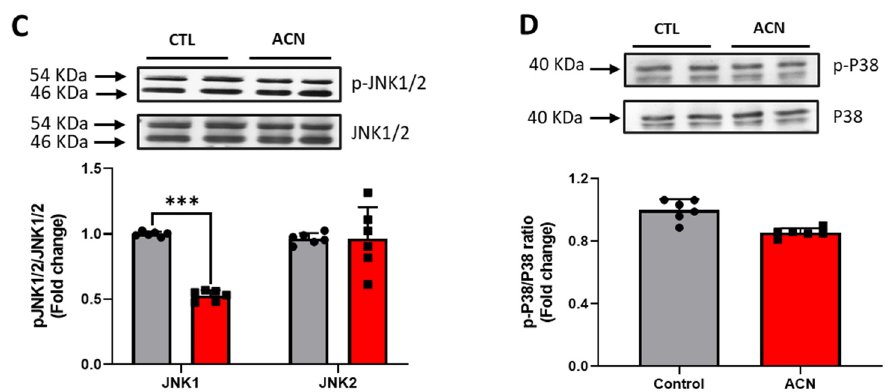
Figure 3. Immunoblotting analysis of proteins extracted from the hippocampus. Crude lysates (20– 40 µg protein) were immunoblotted with antibodies that specifically recognise ( A ) phospho- ERK1/2, total ERK1/2; ( B ) α -E-catenin and GAPDH; ( C ) phospho-JNK1/2, total JNK1/2 and ( D ) phospho-p38, total-p38. Results (phospho/total ratio for ERK1/2, JNK1/2, and p38; protein/GAPDH ratio for α -E-catenin) are presented as means ± SEM ( n = 6). Band intensities were determined by densitometric analysis using Fiji Image J. *** p < 0.001; ** p < 0.01; * p < 0.05: indicate significant differences versus control. CTL = control; ACN = anthocyanins.